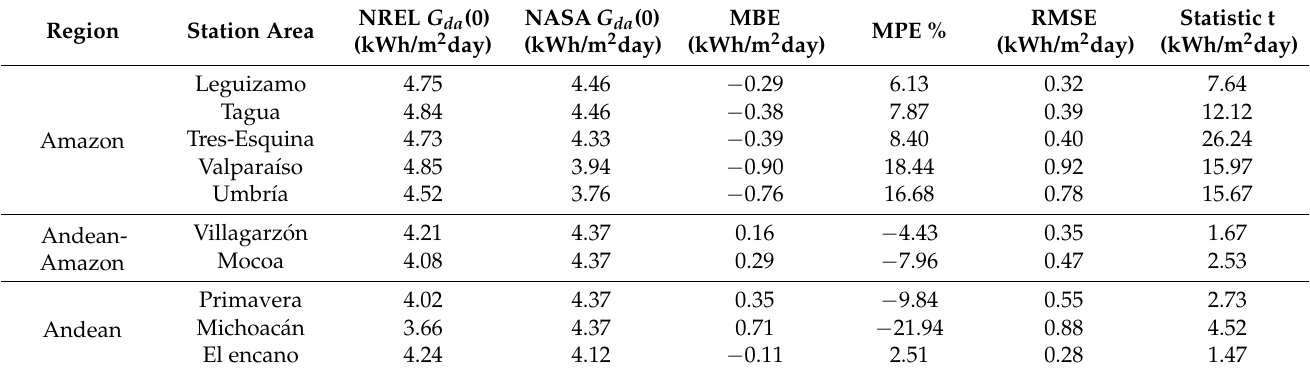
Table 2. Comparison of irradiance values ( G da ) calculated from NREL and NASA databases.